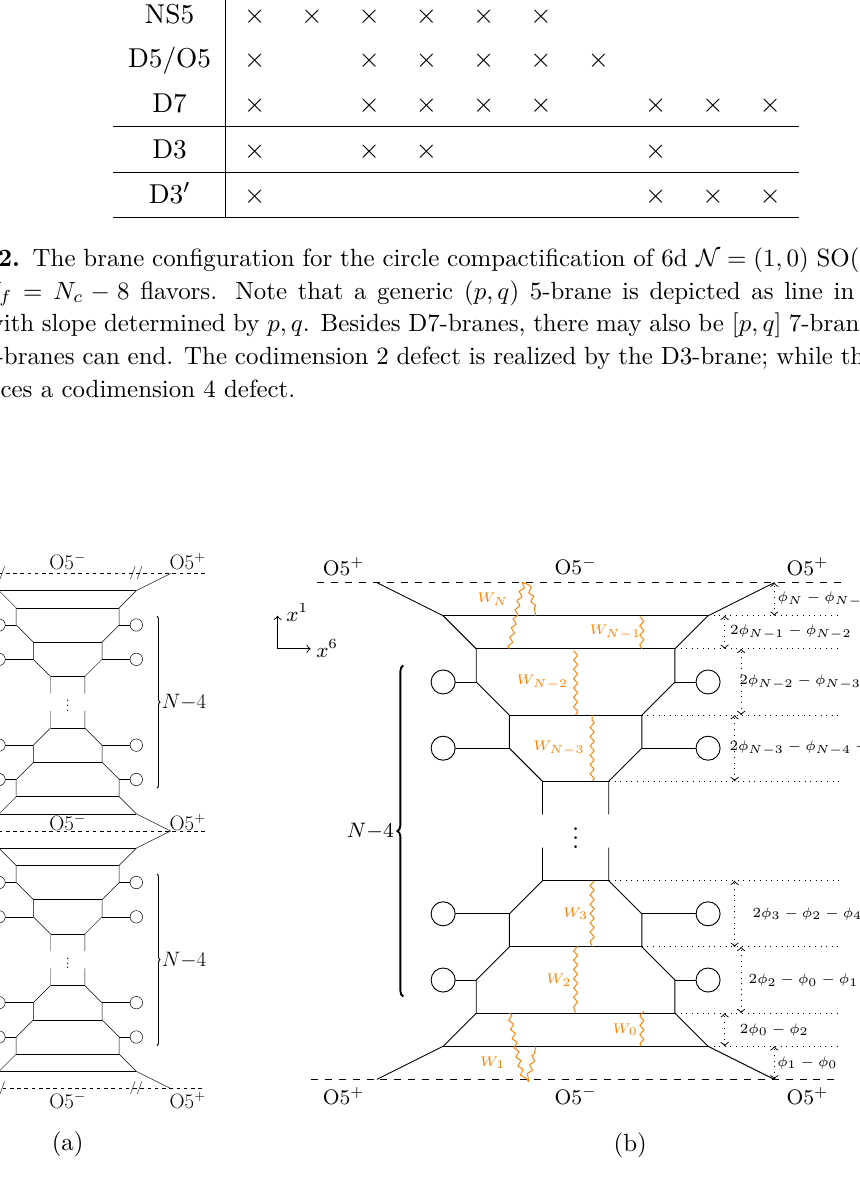
Figure 4. 5-brane web for the 6d SO(2 N ) gauge theory compactified on a circle. In (a), the covering space of the 5-brane web is shown; that is the T-dual of figure 1(a), which contains two O5-planes and the x 1 direction (here the vertical direction) is a circle. For the remainder of the paper, only half of 5-brane web is drawn as in (b), because it contains all relevant information. The flavor D5-branes have been terminated on (half) 7-branes, denoted by (cid:13) . These (half) [1 , 0] 7-branes are T-dual to the half D8-branes from the Type IIA configuration. The monodromy cuts of the 7-branes have been